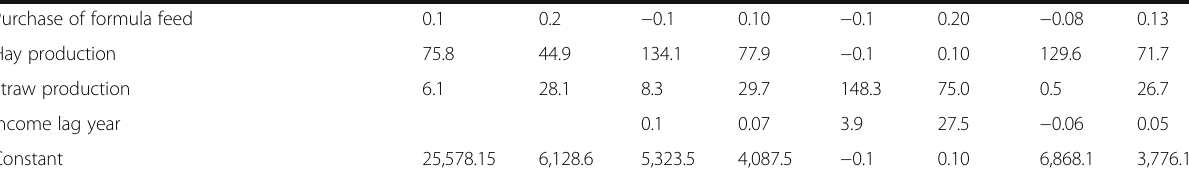
Table 8 Regression outputs of dynamic fixed effects model against the dependent variable (Continued) Purchase of formula